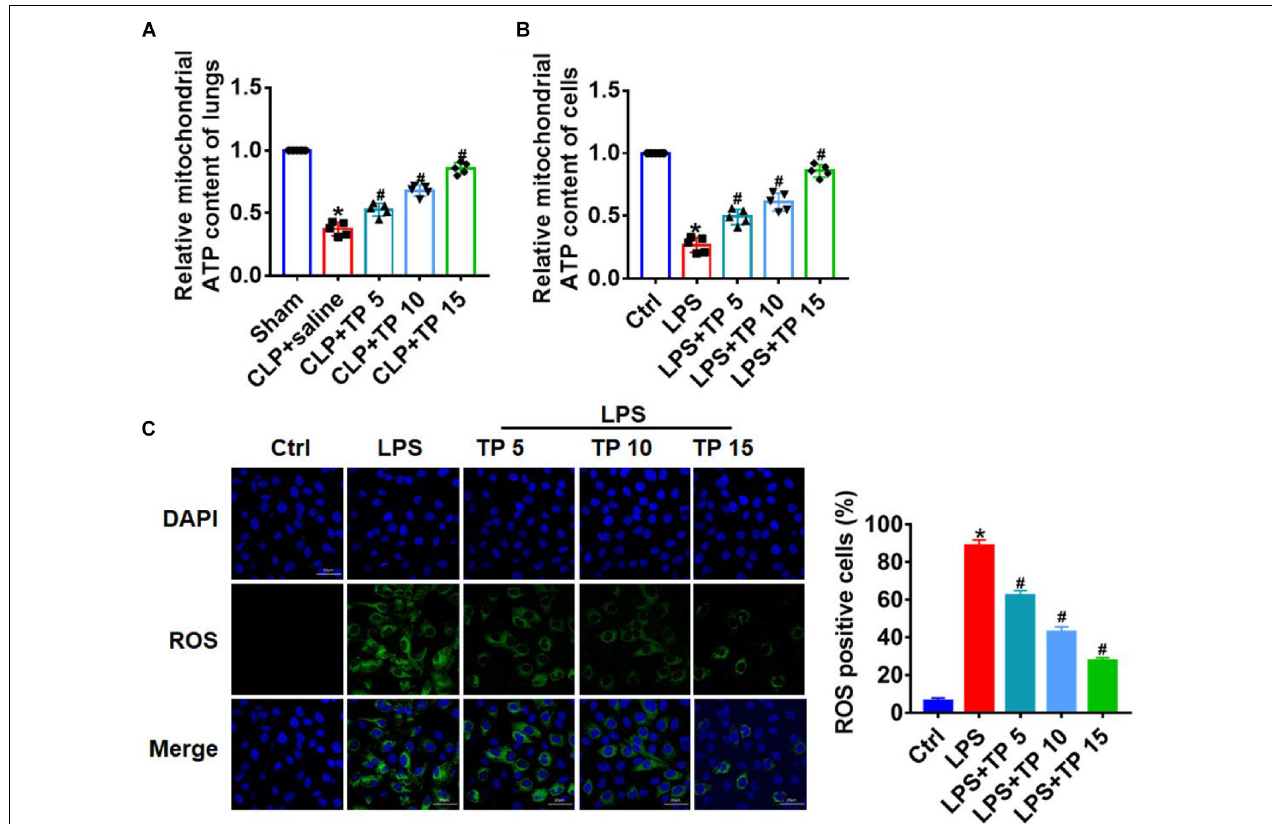
FIGURE 4 | TP reversed CLP/LPS-induced mitochondrial abnormalities. (A) ATP content was detected in lungs from rats. n = 5, * P < 0.05 vs. Sham, # P < 0.05 vs. CLP. (B) ATP content for L2 cells. n = 10, * P < 0.05 vs. control, # P < 0.05 vs. LPS. (C) ROS assay for L2 cells. n = 5, * P < 0.05 vs. control, # P < 0.05 vs. LPS.